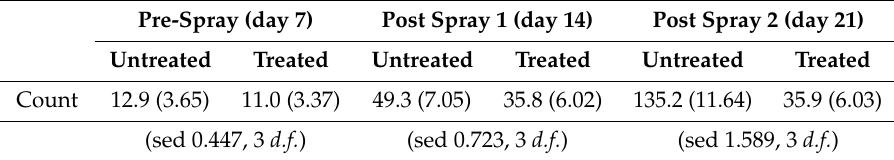
Table 8. Mean total number of B. brassicae nymphs recorded per cabbage plant after two treatments with Botanigard ES in field experiment 1 (square root-transformed data are given in parentheses). Counts of aphid numbers were done immediately prior to spraying on day 7 and day 14, and 7 days after the second spray ( = day 21).